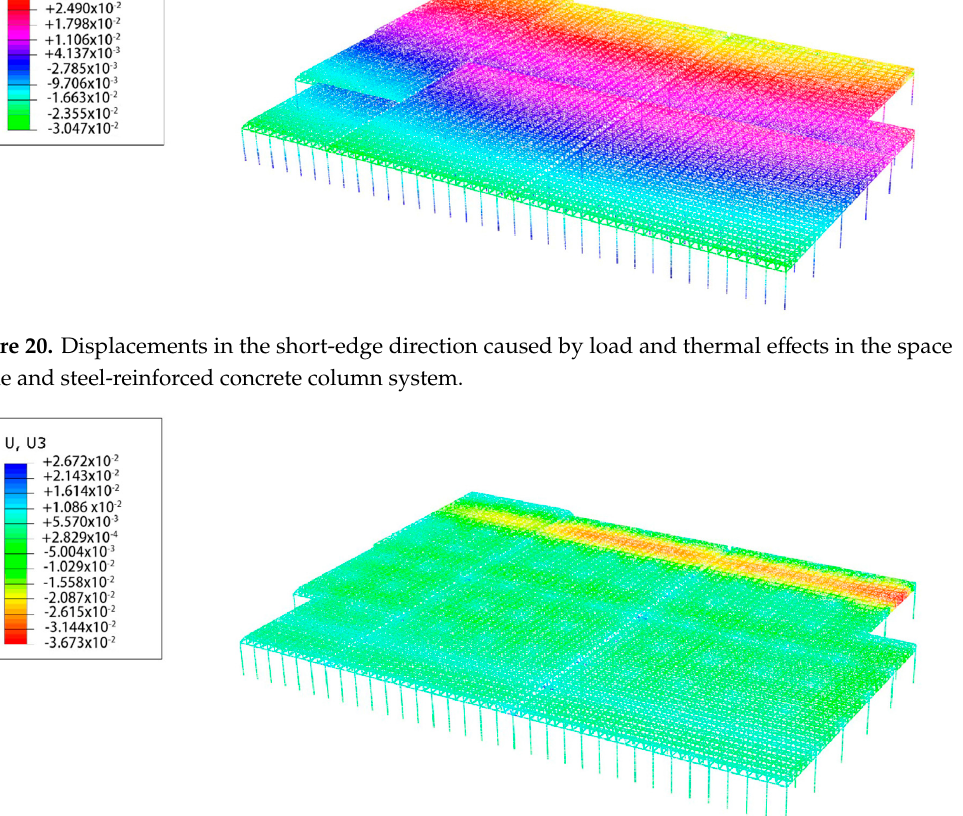
Figure 21. Displacements in the vertical direction caused by the loads in the space frame and steel-reinforced concrete column system.